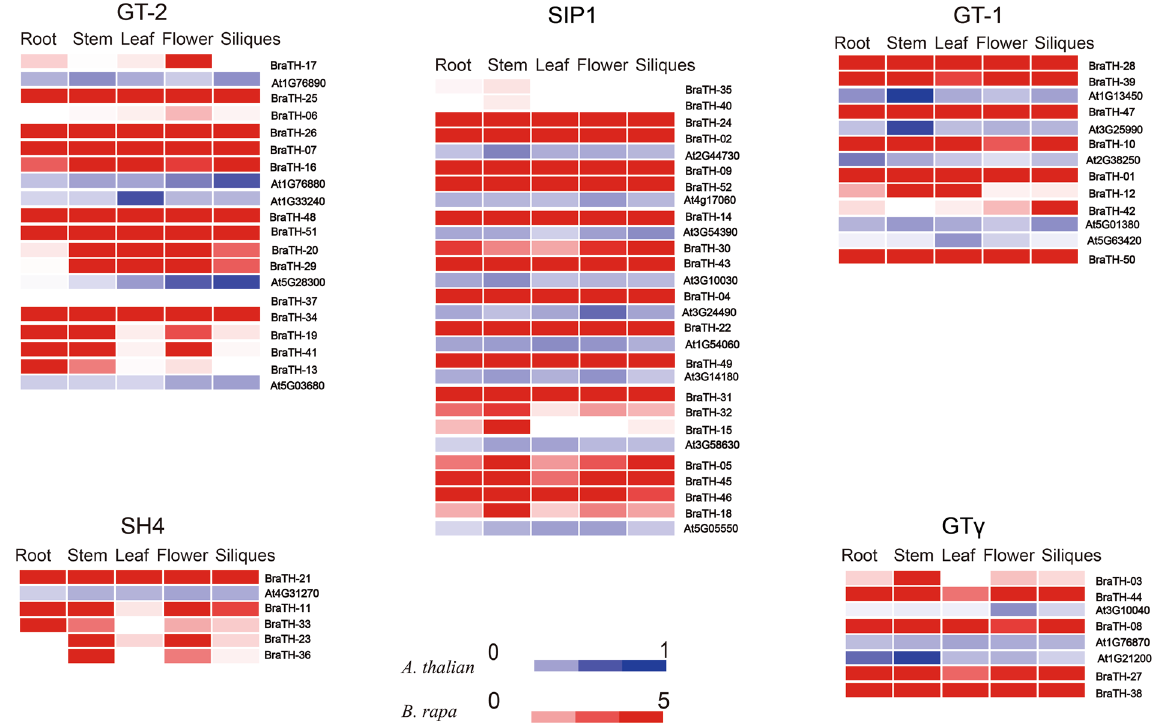
Figure 6. Analysis of the trihelix Genes in Different Tissues of Brassica rapa and Arabidopsis Heat map representation and hierarchical clustering of SIP1, SH4, GT γ , GT-1 and GT-2 genes in root, stem, leaf, flower and